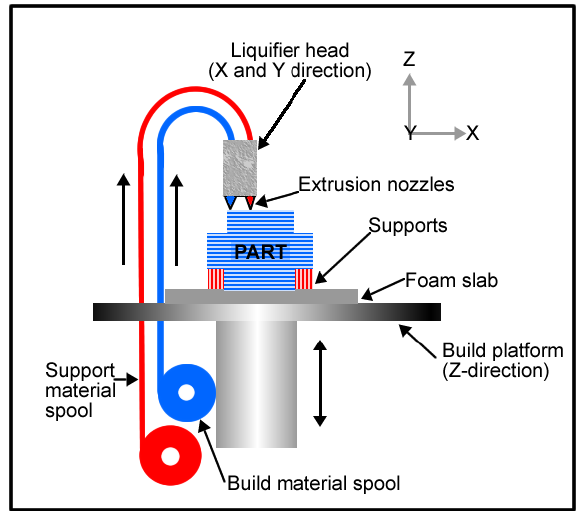
Figure 10. Fused deposition modelling